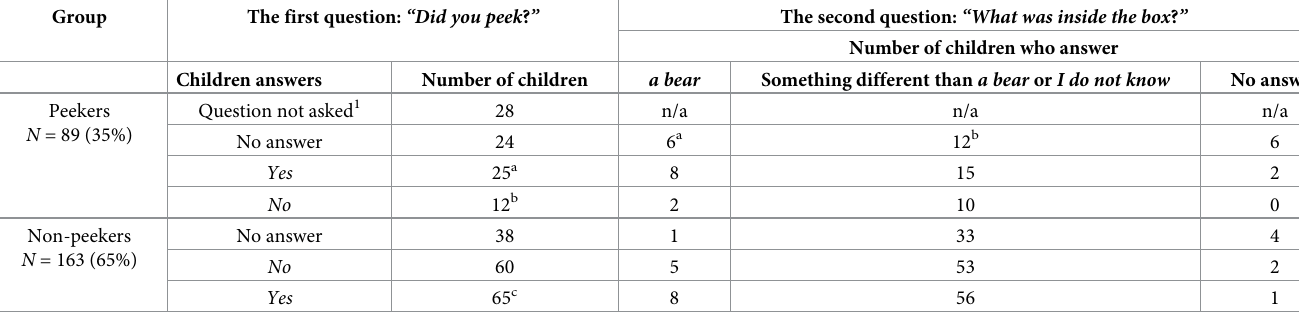
Table 1. Number of children giving different answers in the MTRP in groups of Peekers and non-peekers. Group The first question: “Did you peek ?